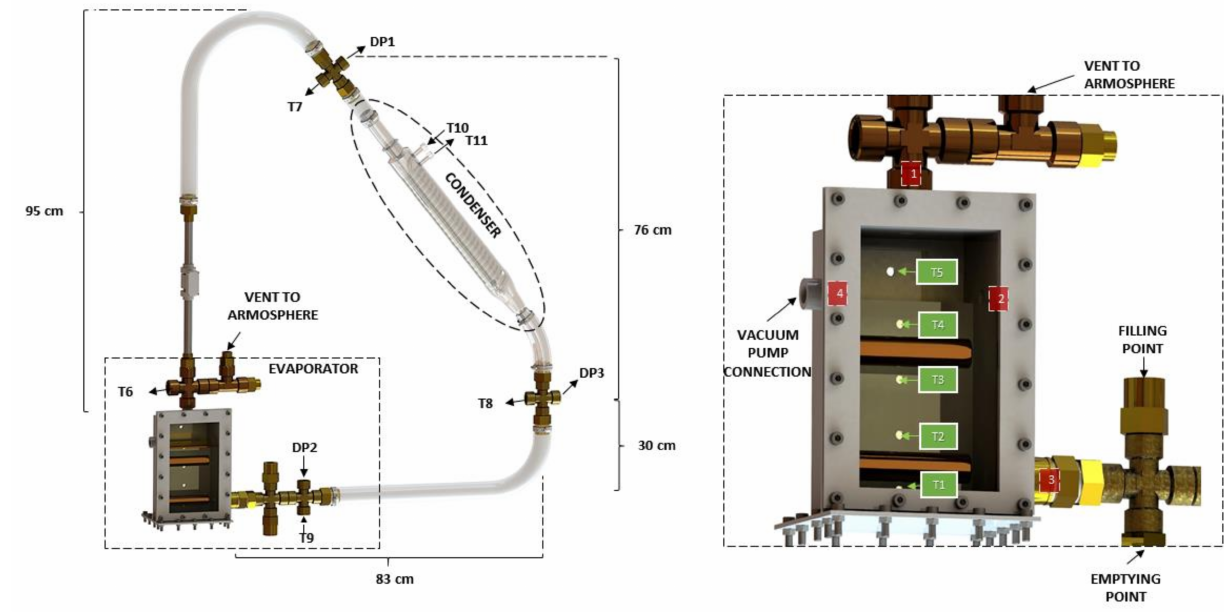
Figure 1. Experimental